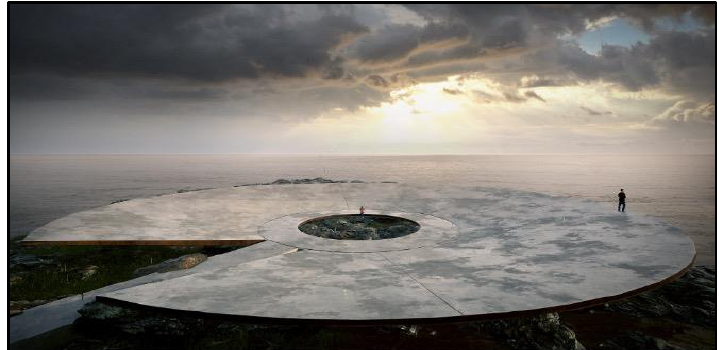
Figure 8. World Memorial to the Pandemic (planned,